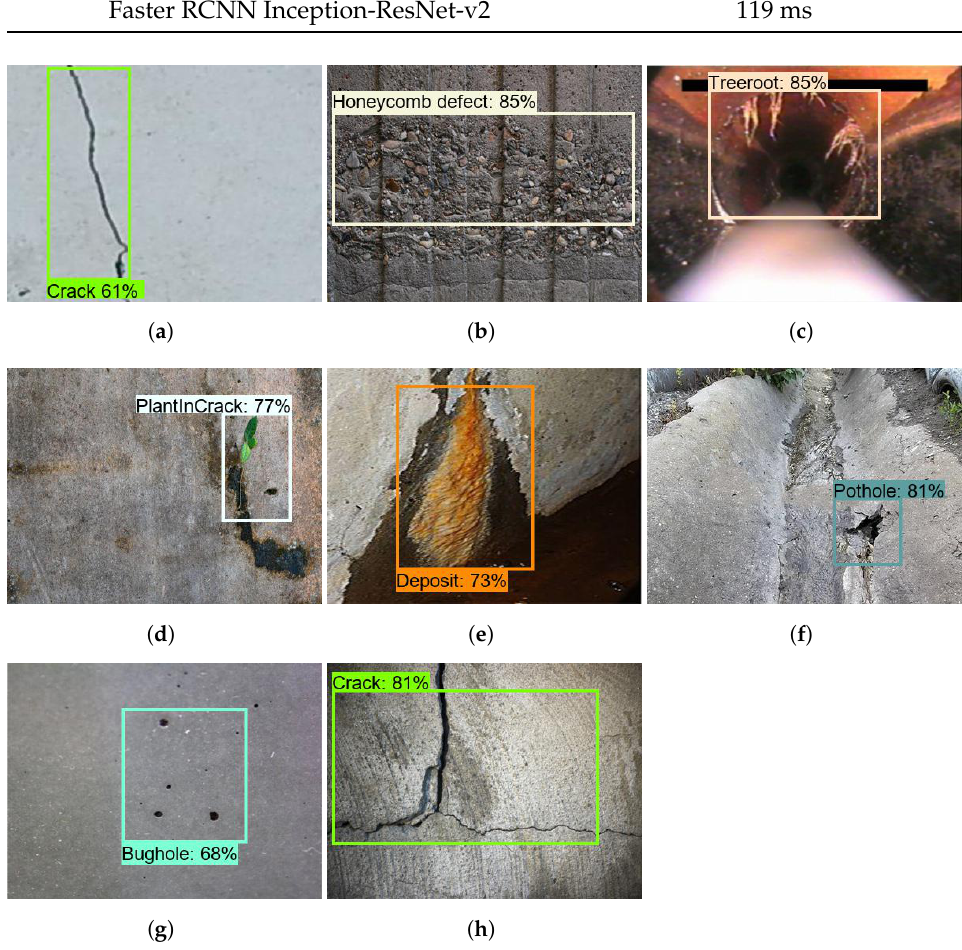
Figure 13. ResNet50 defect detection results. ( a ) Crack; ( b ) Honeycomb defect; ( c ) Tree root intrusion; ( d ) Plant intrusion; ( e ) Deposit; ( f ) Pothole; ( g ) Bughole; ( h )